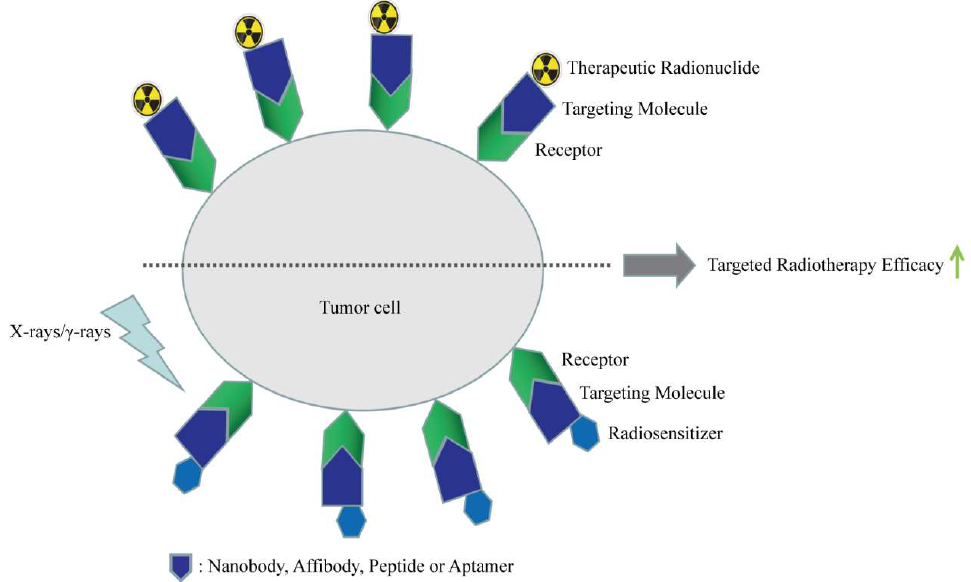
Figure 3. Applications of affinity molecules in radiotherapy. The affinity molecules mainly include nanobody, affibody, peptide, and aptamer, and they can carry therapeutic radionuclides and radiosensitizers to enhance the efficacy of radio- therapy.